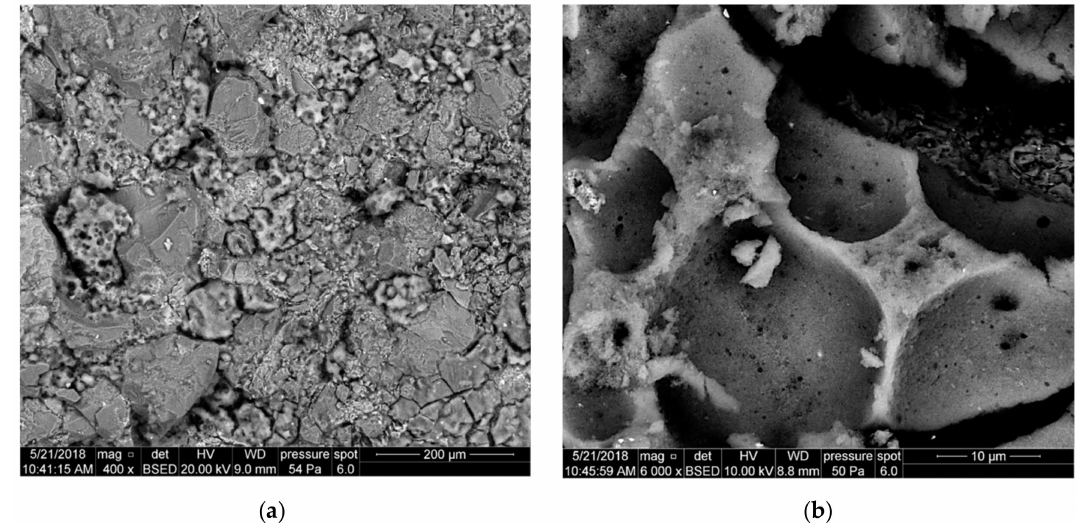
Figure 10. SEM image of the 3232 core face after contact with foamed Areosil S.F. 1b, ( a ) top view of the core face, ( b ) top view of the core face at a high magnification.